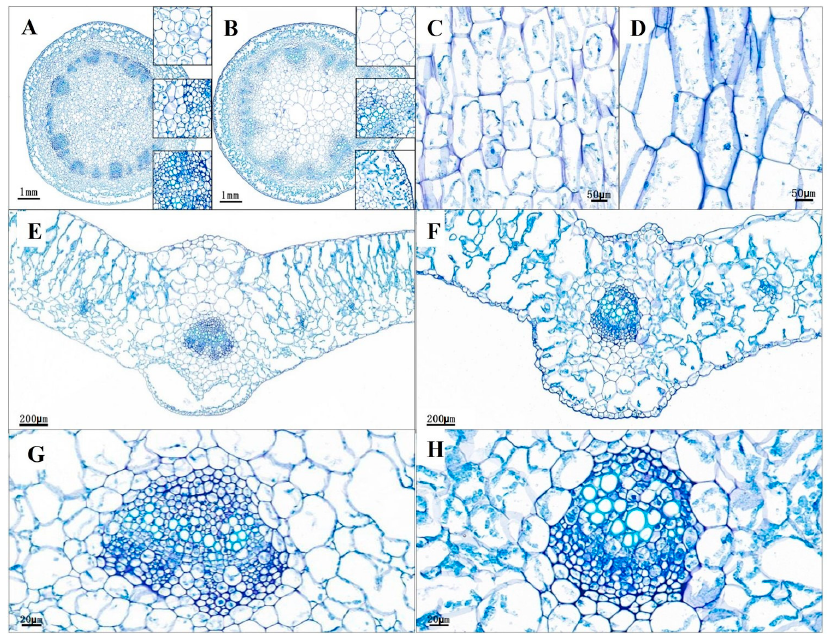
Figure 5. Stem and leaf cell morphology of Brcd1 YS and YS. Paraffin sections were used to identify the stem and leaf cell morphologies of Brcd1 YS and YS. ( A ): Stem cross section of YS; ( B ): stem cross section of Brcd1 YS , scale bars = 1 mm. ( C ): Magnified stem section of YS; ( D ): magnified stem section of Brcd1 YS , scale bars = 50 µ m. ( E ): Leaf section of YS; ( F ): leaf section of Brcd1 YS , scale bars = 200 µ